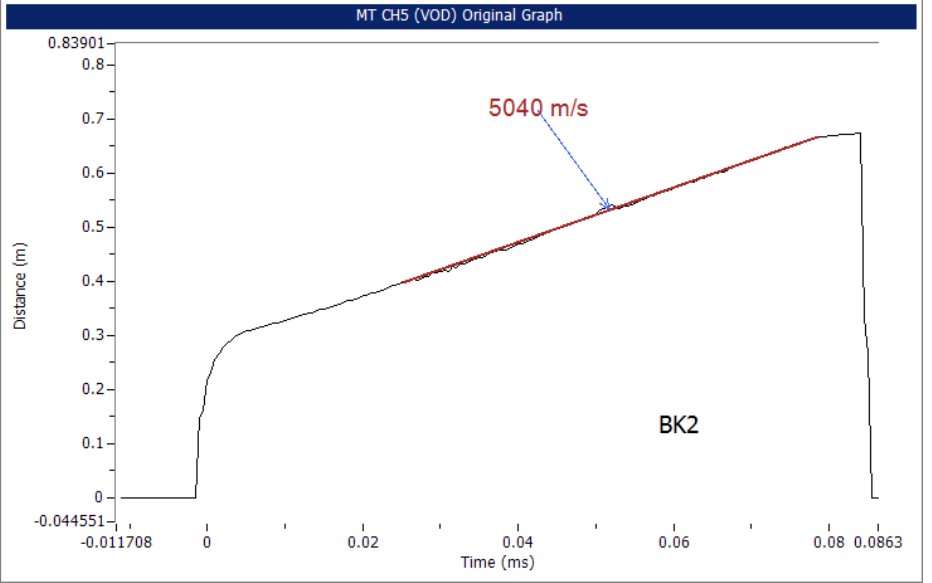
Figure A1. Sample distance vs. time curve, from which the velocity of detonation for the BK2 EE formulation was determined